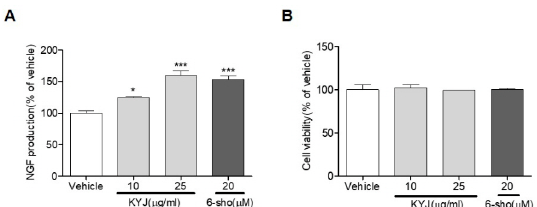
Figure 1. The mixture of Gotu Kola, Cnidium fruit, and Goji berry (KYJ) stimulated the release of nerve growth factor (NGF) in C6 cells. ( A ) Cells were treated with KYJ (10 and 25 µg/mL) or 6-shogaol (20 µM, positive control), and the NGF concentration was measured in culture media. ( B ) The cell viability was expressed as the result of MTT assay. Three independent experiments were performed. * p < 0.05 and *** p < 0.001 vs. vehicle-treated group.